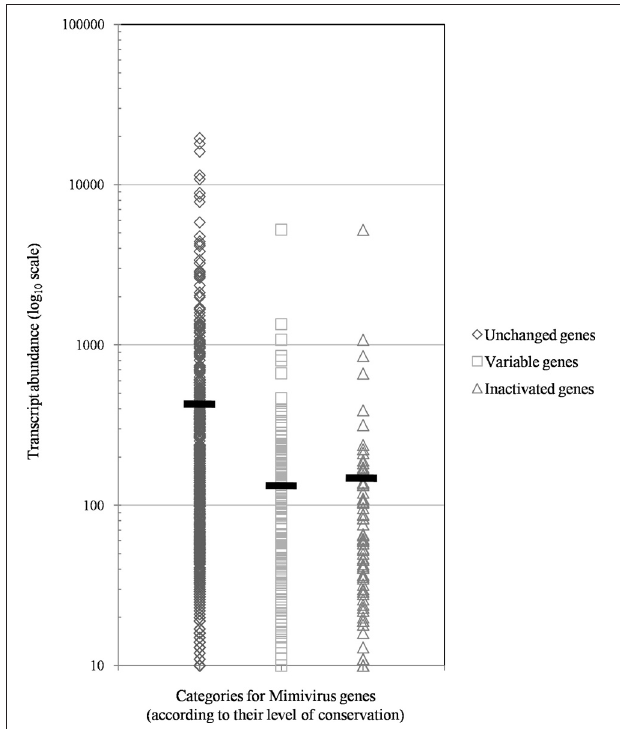
FIGURE 5 | The distribution of transcript abundance in Mimivirus M1 for different groups/subgroups of genes defined based on their variability and evolution during 150 passages in allopatric laboratory culture on amoebae. The horizontal bars indicate the mean values for each group/subgroup.